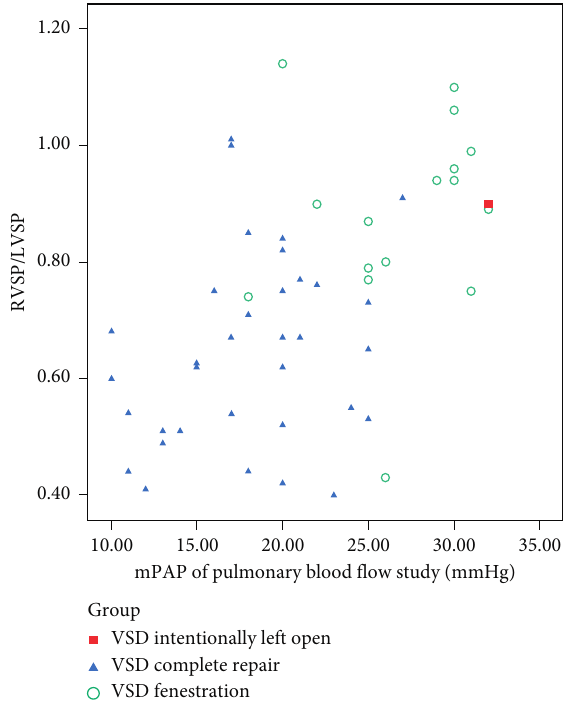
Figure 2: Scatter plot of mPAP (mean pulmonary artery pressure) and postoperative RVSP (right ventricular systolic pressure)/LVSP (left ventricular systolic pressure) ratio for 53 subjects who un- derwent pulmonary blood flow studies.